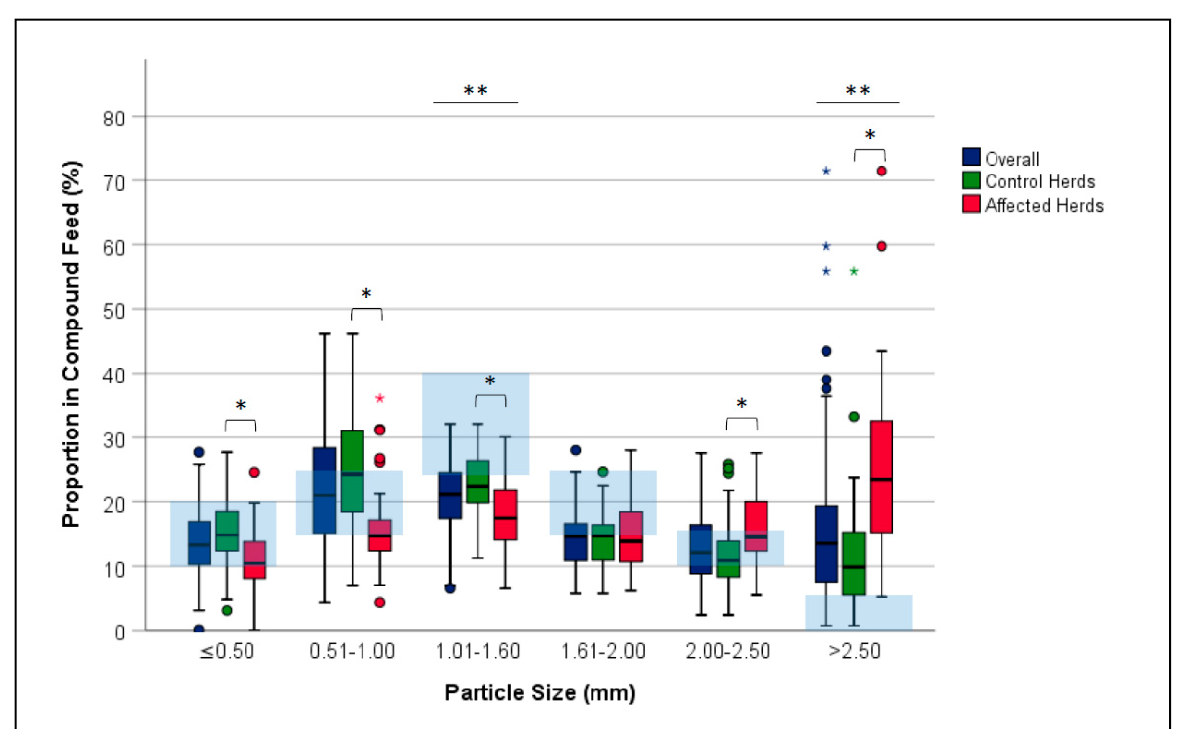
Figure 2. Box-whisker plots illustrating the proportions of feed particle fractions in compound feed samples ( n = 103) from laying hen herds with and without behavioral disorders.* significant differences ( p ≤ 0.05) in the proportions of the respective particle size fraction between control and affected herds; ** significant differences in the proportions of the respective particle size fraction between the compound feed samples (overall) and the reference range (light blue shaded) according to Pottgüter et al. [19]. Table 4. Effects of hybrid type, age and geometric mean diameter of feed particles on the occurrence of plumage damage in laying hen herds—results of a logistic regression